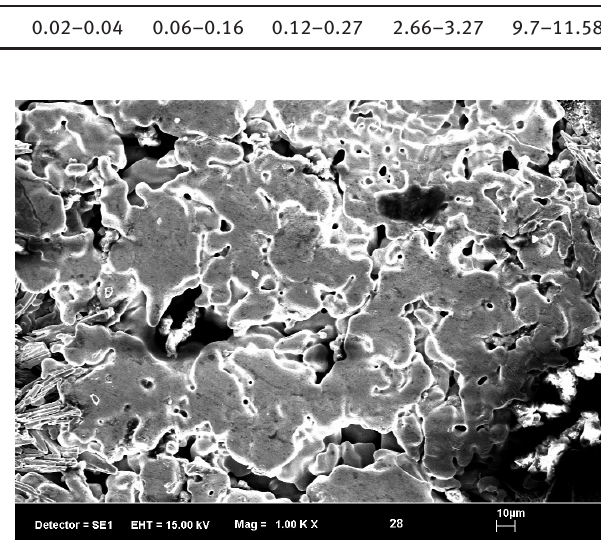
Table 1 Chemical composition of AstaloyCr-M (%). Powder